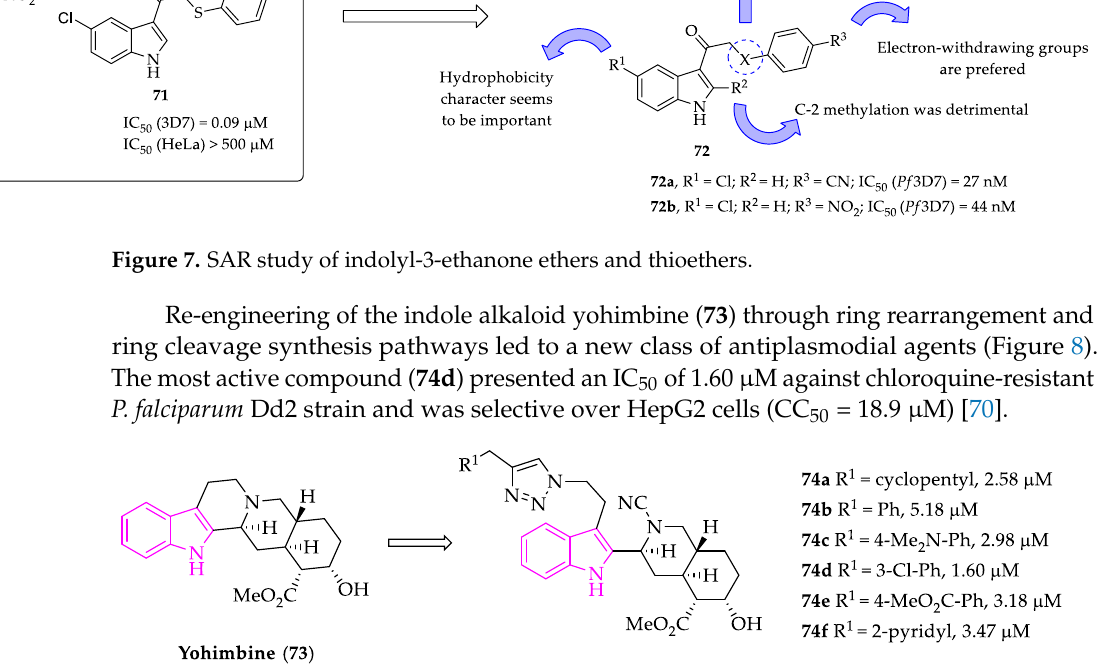
Figure 8. Yohimbine ( 73 ) ring distortion led to analogs active against Dd2.